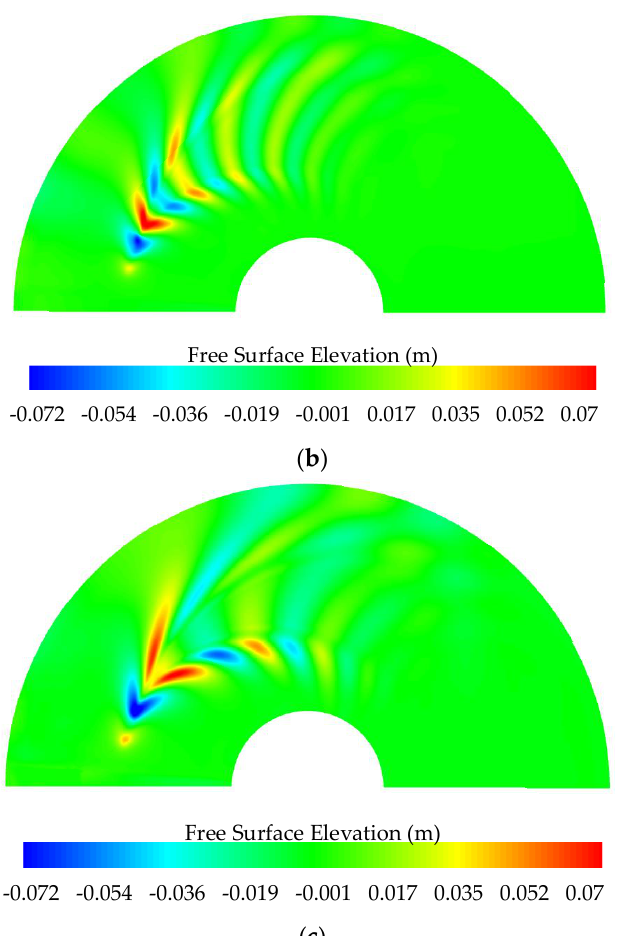
Figure 9. Characteristics of wakes at the free surface at different velocities. ( a ) Fr = 0.3, ( b ) Fr = 0.5, ( c ) Fr = 0.7.